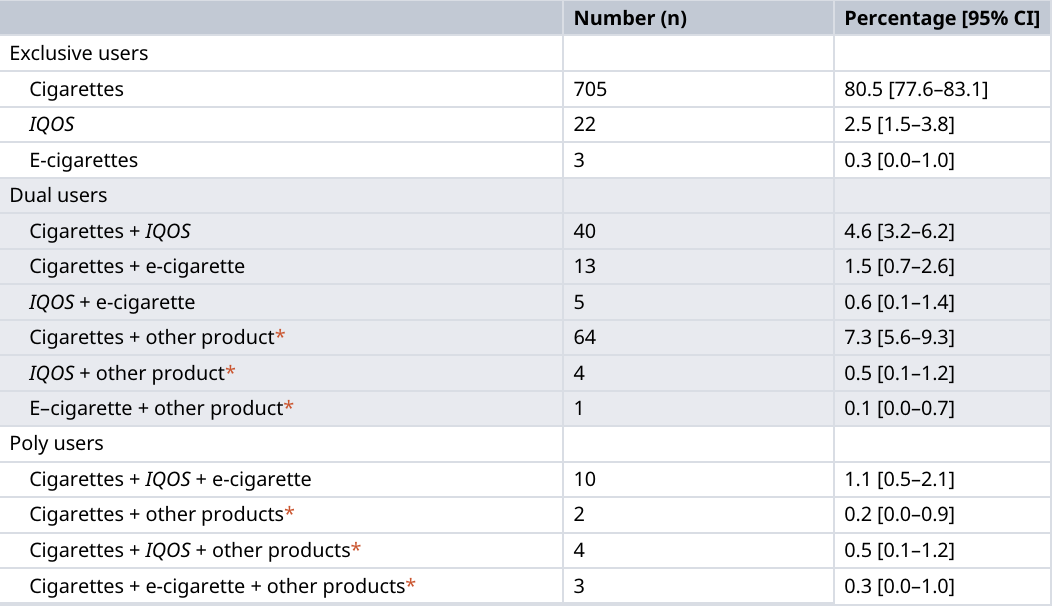
(16.8 HeatSticks ) than among dual and poly users, who used 13.8 and 12.8 HeatSticks , respectively. The average daily consumption of cigarettes was 11.0 among dual cigarette and IQOS users and 12.8 among poly users.